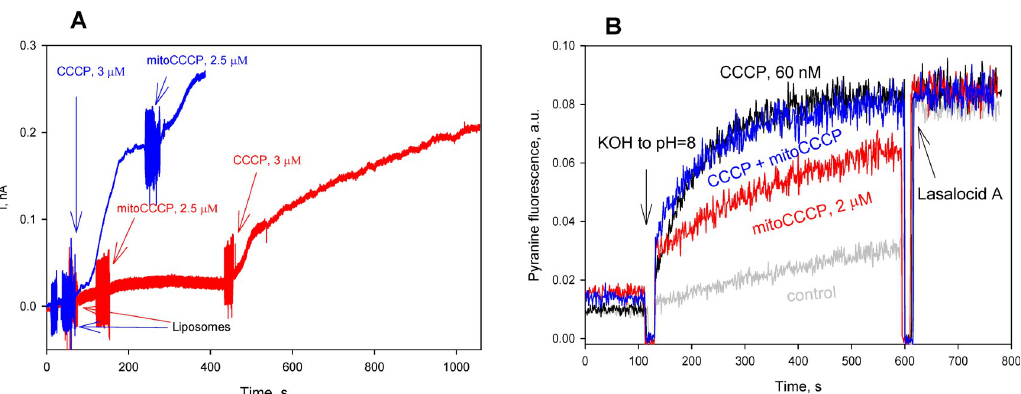
Fig 4. A . Effect of mitoCCCP (2.5 μ M) on the CCCP (3 μ M)—mediated electrical current through planar bilayer lipid membrane (BLM) made from DPhPC. The solution was 50 mM Tris, 50 mM MES, 10 mM KCl, 10 μ g/ml EggPC liposomes, pH 7.4. The voltage applied to BLM was 50 mV. B . Effect of mitoCCCP (2 μ M) on the CCCP (60 nM)–mediated proton fluxes through liposomes loaded with the pH-probe pyranine. Inner liposomal pH was estimated from the pyranine fluorescence intensities measured at 505 nm upon excitation at 455 nm. 1 μ M lasalocid A was added at 600 s to equilibrate the pH. Other conditions: see Materials and Methods. Lipid concentration was 20 μ g/ml.